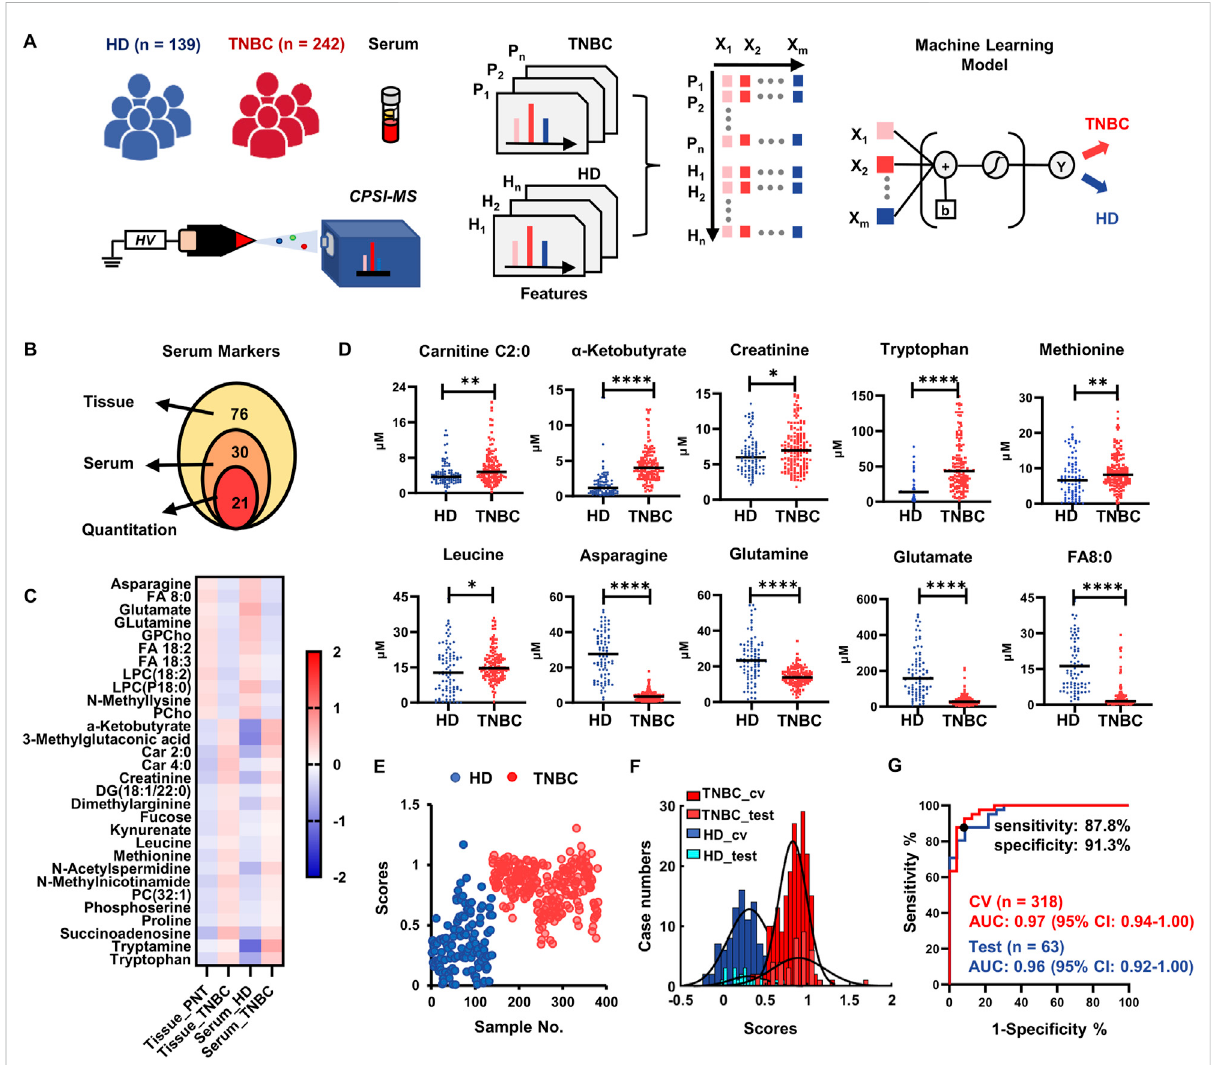
FIGURE 3 Results of serum validation for metabolite markers discovered in tissue. (A) Diagram of recruited cohort of healthy donor (HD), TNBC patients, CPSI-MS screening for serum metabolomics, and machine learning process; (B) Venn graphs display the number of metabolites that are fi nally selected as serum screening markers and used for quantitative estimation; (C) Heatmap visualization indicate the consistent tendencies of these characteristic metabolites in tissue and serum; (D) The quantitative comparison of representative 10 metabolite markers in serum; (E) The scores predicted by Lasso classi fi er on the 381 TNBC and HD serum samples; (F) Histograms display the distribution of HD and TNBC samples in the training and test sets; (G) ROC curve for assessing the performances of the metabolite markers-based Lasso model for TNBC screening. * p <